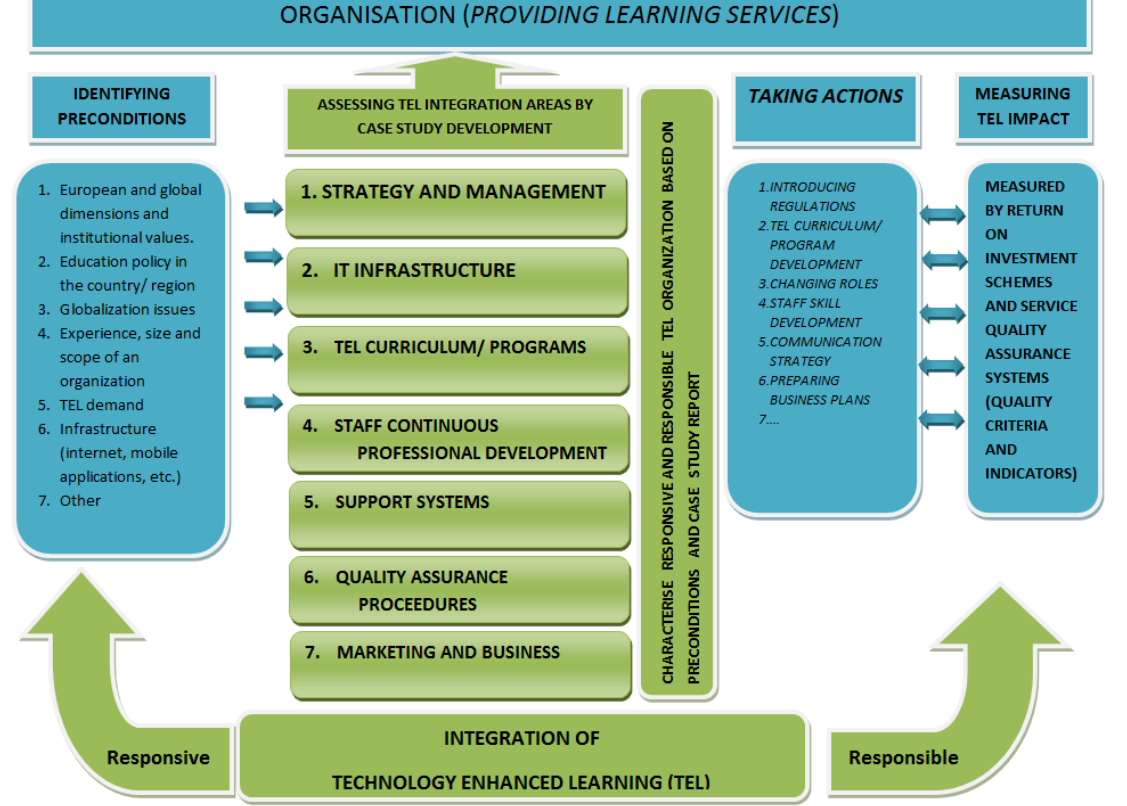
Figure 1 . The model of TEL integration in an